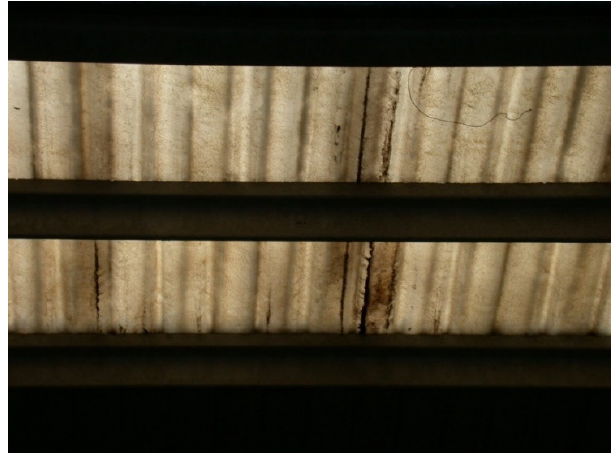
Figure 7. Example of a damaged exposed asbestos cement roofing in indoor environments.